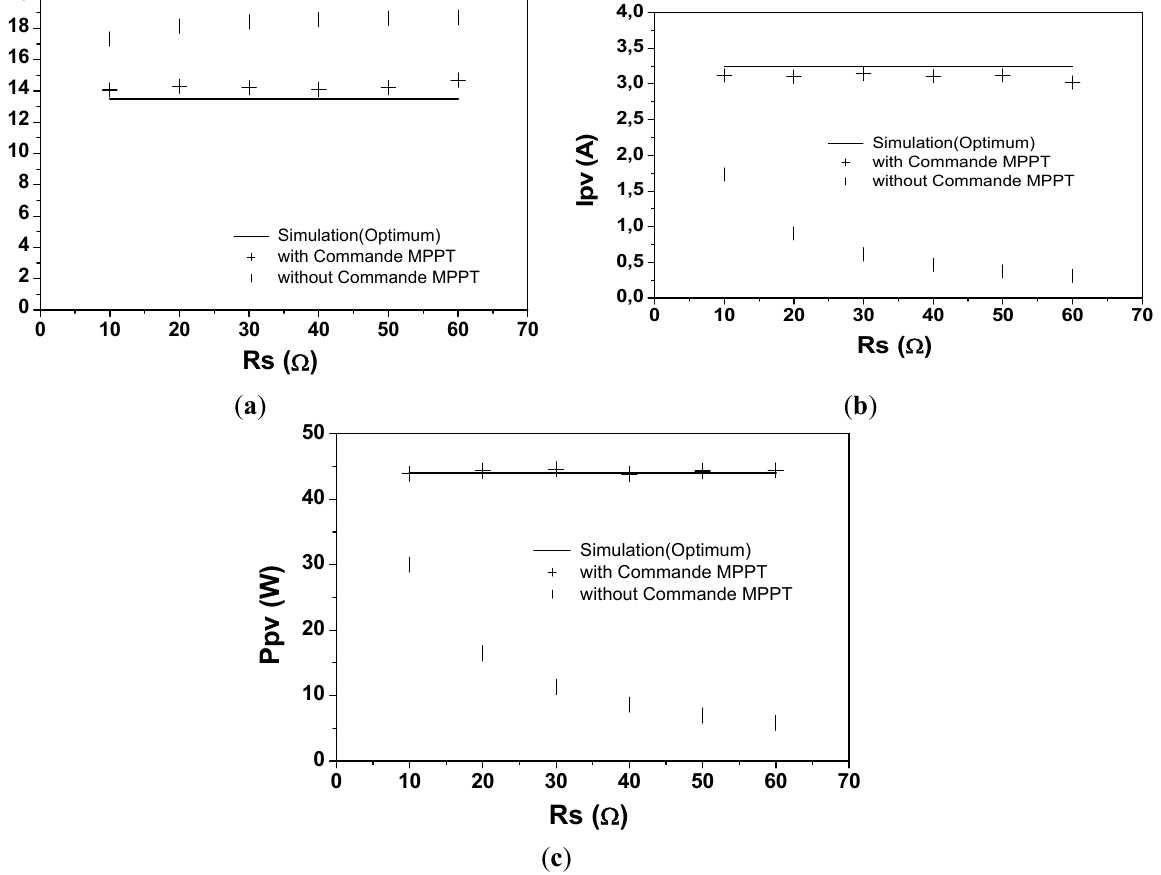
without Digital MPPT Control.